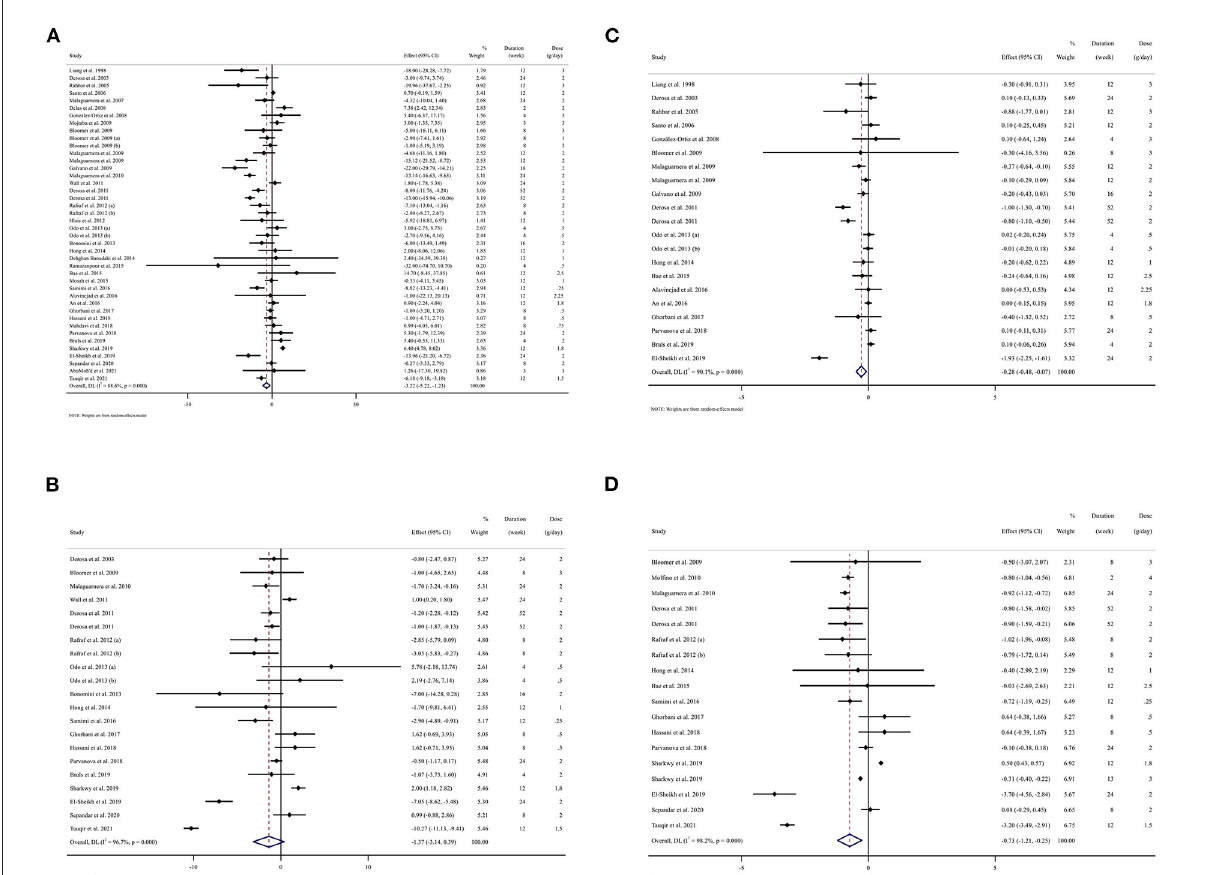
FIGURE2 Forest plot detailing weighted mean difference and 95% confidence intervals (CIs) for the effect of L-carnitine consumption on (A) FBG (mg/dl); (B) Insulin (pmol/l); (C) HbA1c (%); (D) HOMA-IR. FBG, fasting blood glucose; HOMA-IR, homeostasis model assessment for insulin resistance; hemoglobin A1C, HbA1C; CI, confidence interval, weighted mean difference; WMD. Horizontal lines represent 95% of CIs. Diamonds represent pooled estimates from the random-effects